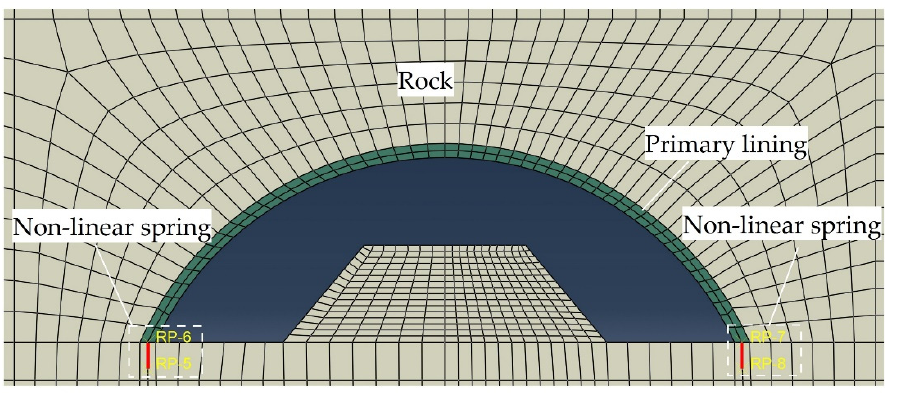
Figure 11. Numerical calculation model.